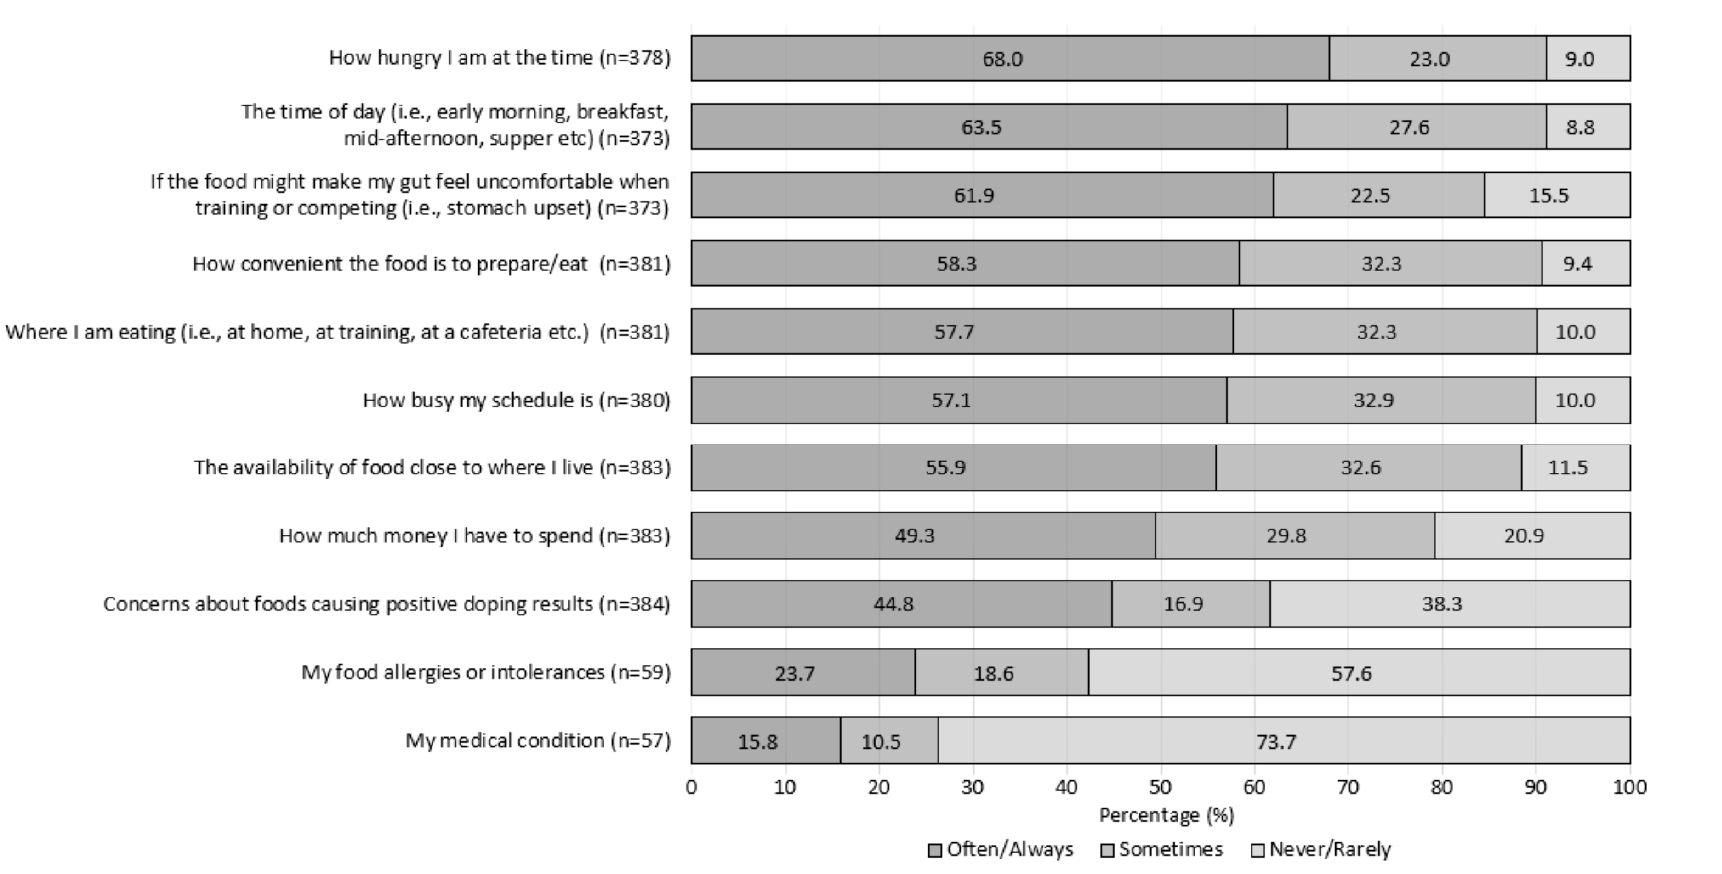
Figure 1. Figure: the percentage of athletes ( n = 385), who rated how frequently (never/rarely, sometimes and often/always) 11 items influence their food choices.